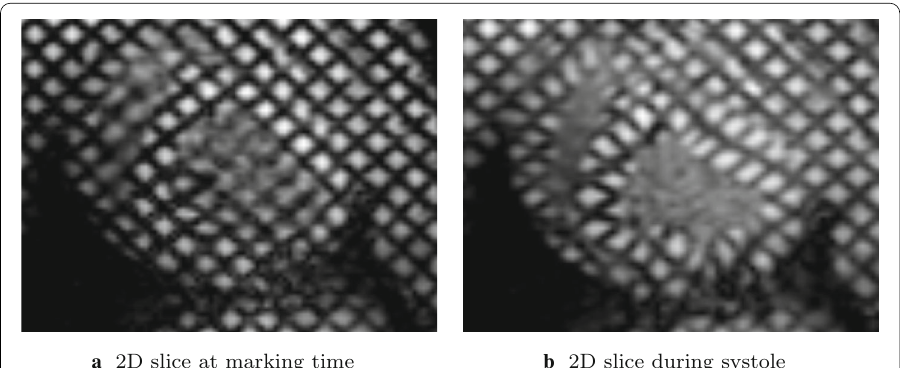
Fig. 1 Example of SPAMM images in short axis